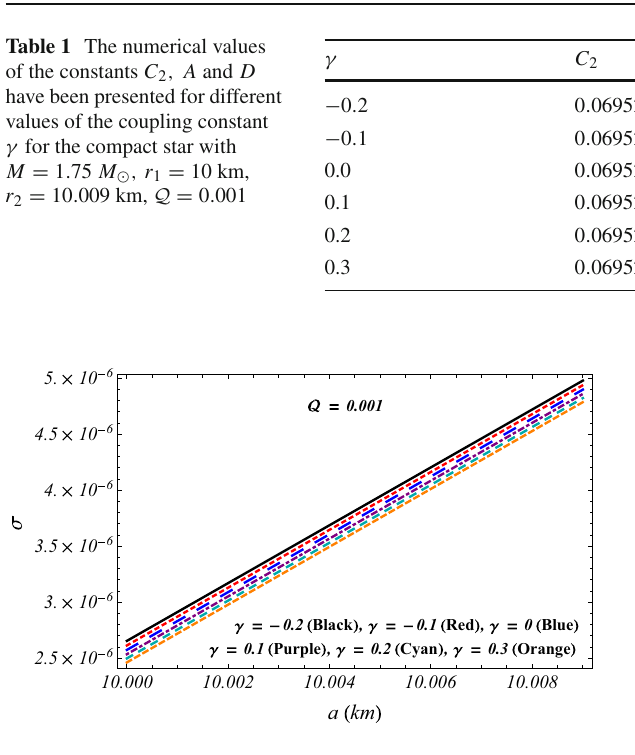
Fig. 4 Variation of surface energy density inside the thin shell